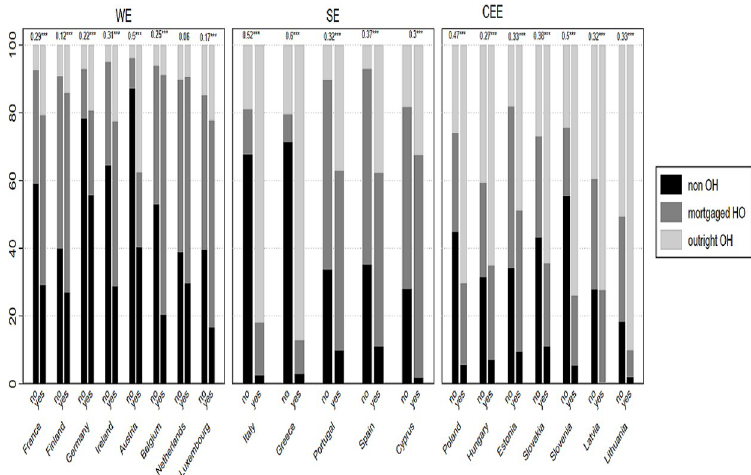
Fig 1. Housing tenure categories by IWT and country. Note. Outside the Bars; Cramer’s V and P values ��� p < 0.05, �� p < 0.01, � p < 0.001, Countries are placed in descending order.